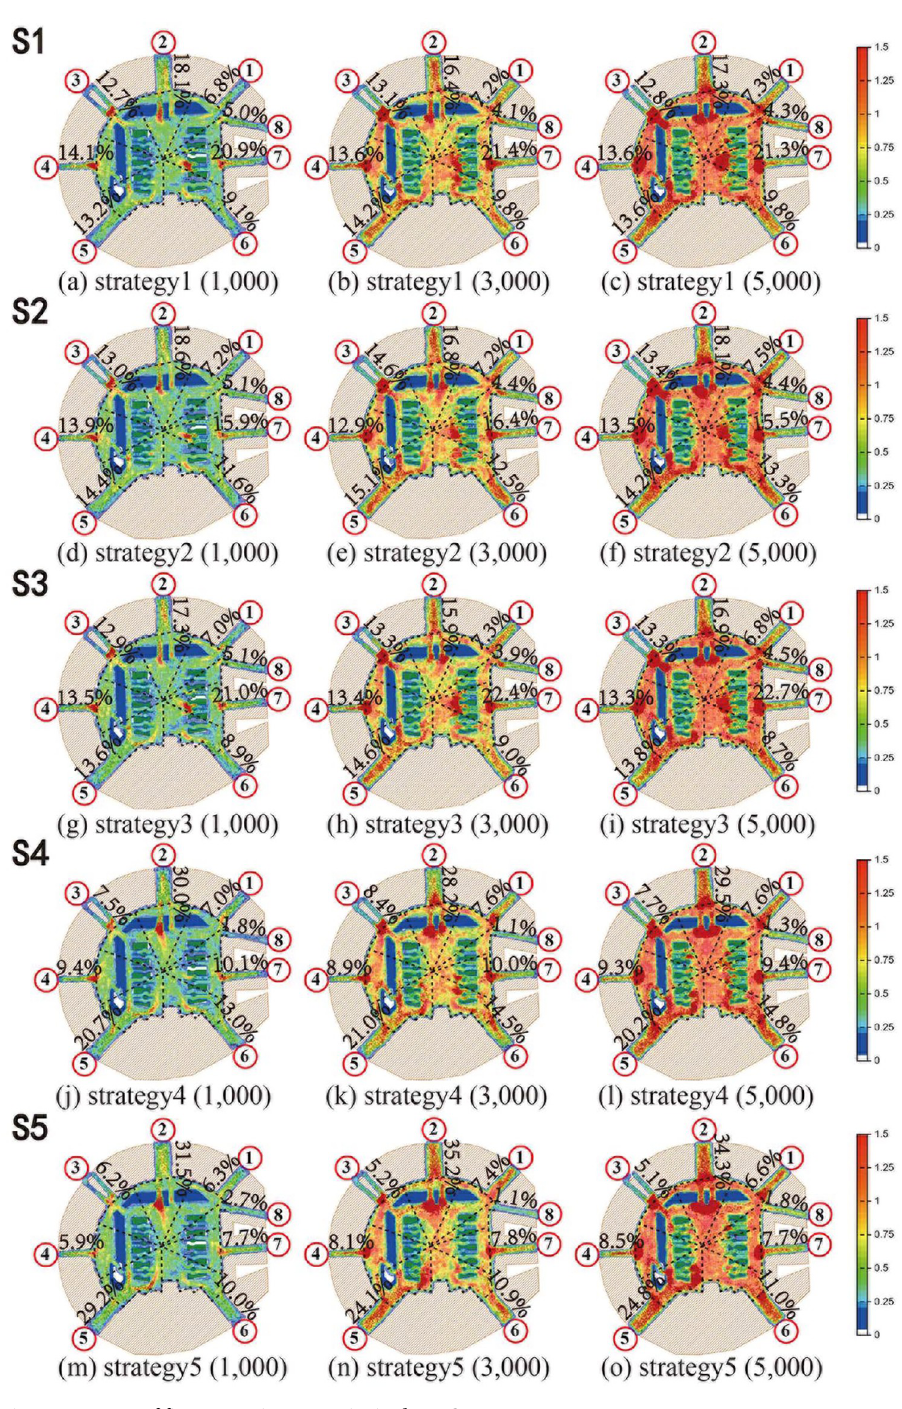
Fig 4. Heatmaps of five evacuation strategies in the LPS. color indicates a high-density area, and crowd density is greater than 1.25 m 2 ; the blue color represents a low-density area of crowds, and pedestrian density is less than 0.5 m 2 . In Fig 4, the percentage value indicates the proportion of evacuees in each evacuation experiment, which reflects the influence of different strategies on the evacuation route choice.